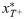
Population densities for stable equilibria.Population densities xT+*, xTP* and xT-*, corresponding to stable equilibria for Λ ∈ [0, 1] and for α32 = 2.0. The gray highlighted regions show the stable equilibria that are within the patient viability constraint (5). The yellow highlighted points represent two specific stable equilibria chosen for further analysis.